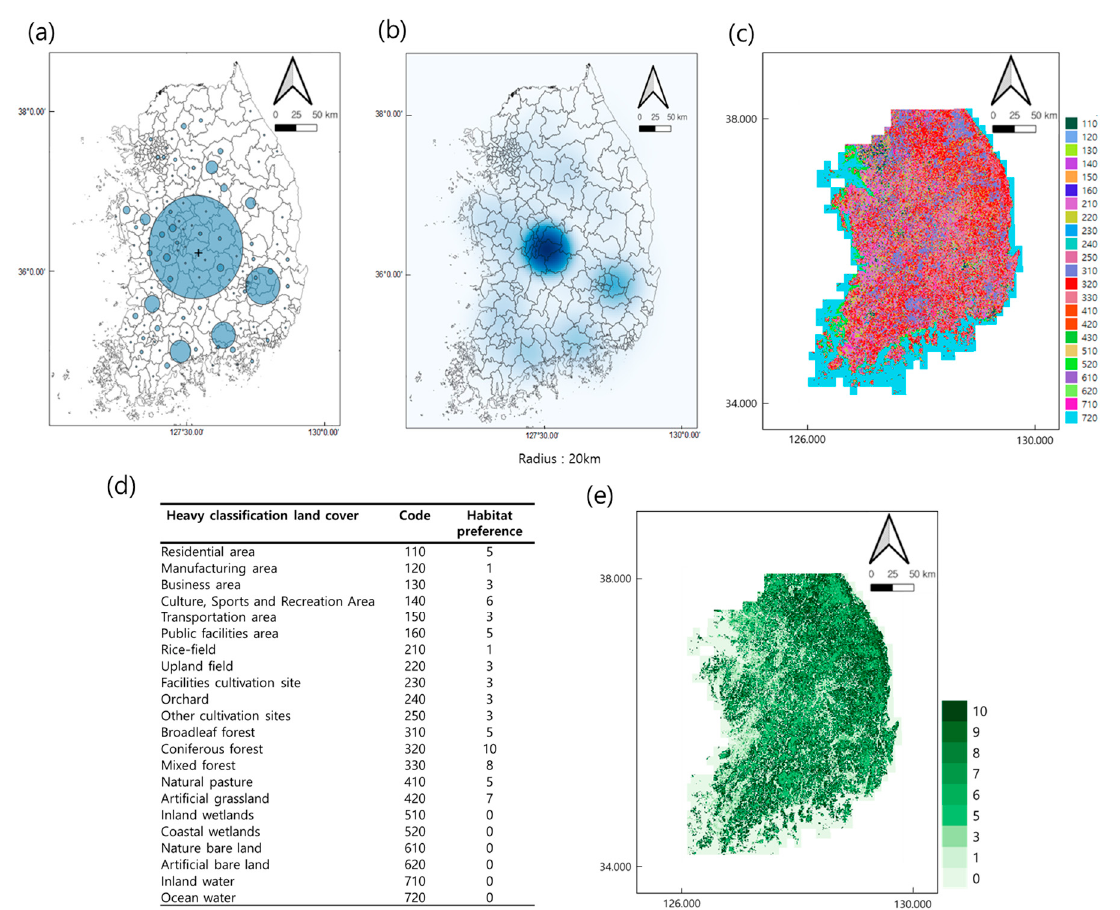
Figure 3. Distribution of sapling farms in Korea (blue circles presenting the number of sapling farms in local areas) ( a ), heat map (Radius = 20 km; stronger blue tones indicating higher densities) ( b ), map of land-cover types ( c ), habitat preference score for the WCSB ( d ), and spatial distribution of habitat preference on the map ( e ).